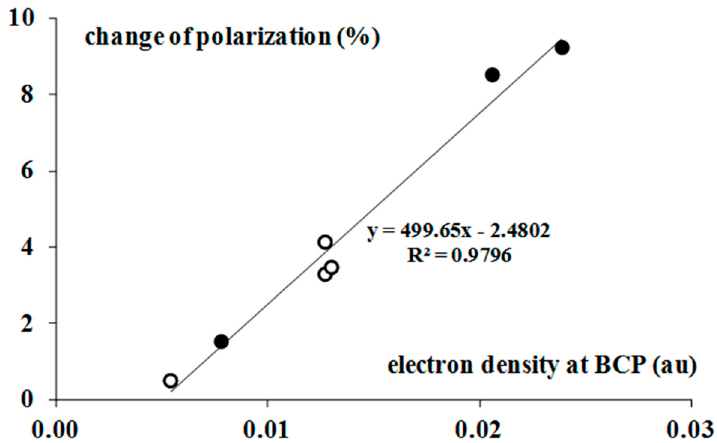
Figure 3. The linear correlation between the electron density at the BCP (in au) of the Lewis acid—Lewis base bond path, and the percentage change of the mean polarization of the Br-F equatorial bond as an effect of complexation; black circles correspond to the BrF 3 complexes while white circles to the BrF 5 complexes.